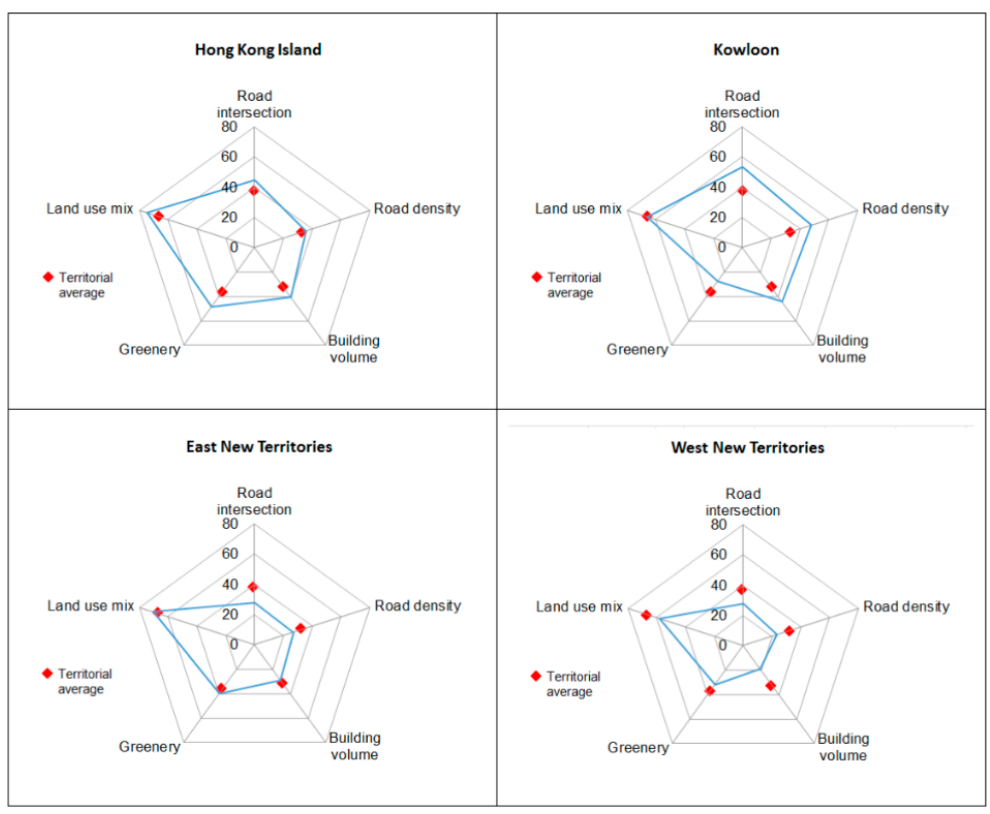
Figure 3. Summary radar charts of morphological metrics (based on mean normalized scores) by geographic regions of Hong Kong.